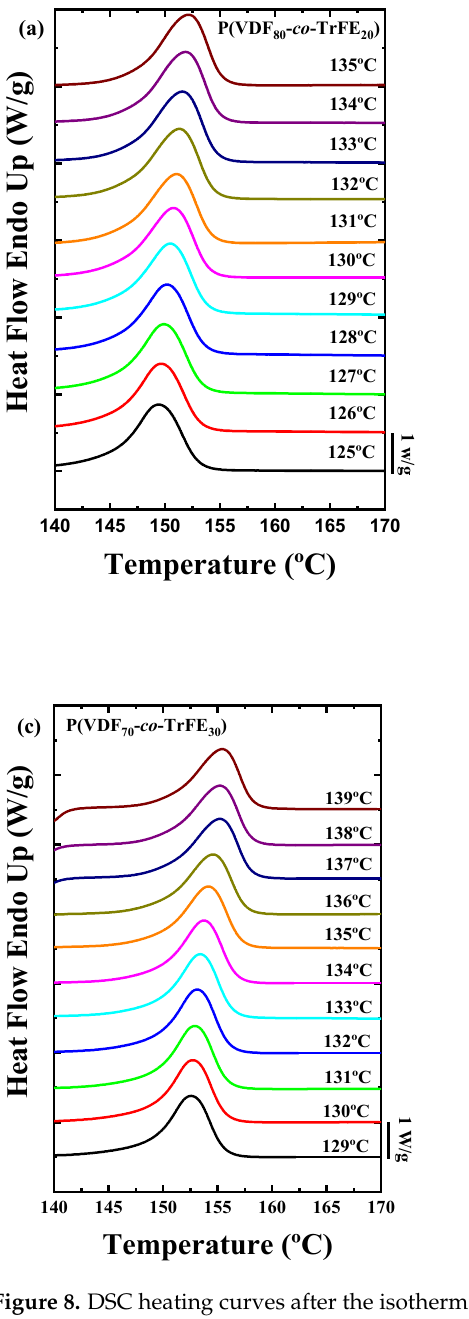
Figure 8. DSC heating curves after the isothermal crystallization process of ( a ) P(VDF 80 - co -TrFE 20 ), ( b ) P(VDF 75 - co -TrFE 25 ), and ( c ) P(VDF 70 - co -TrFE 30 ) samples.